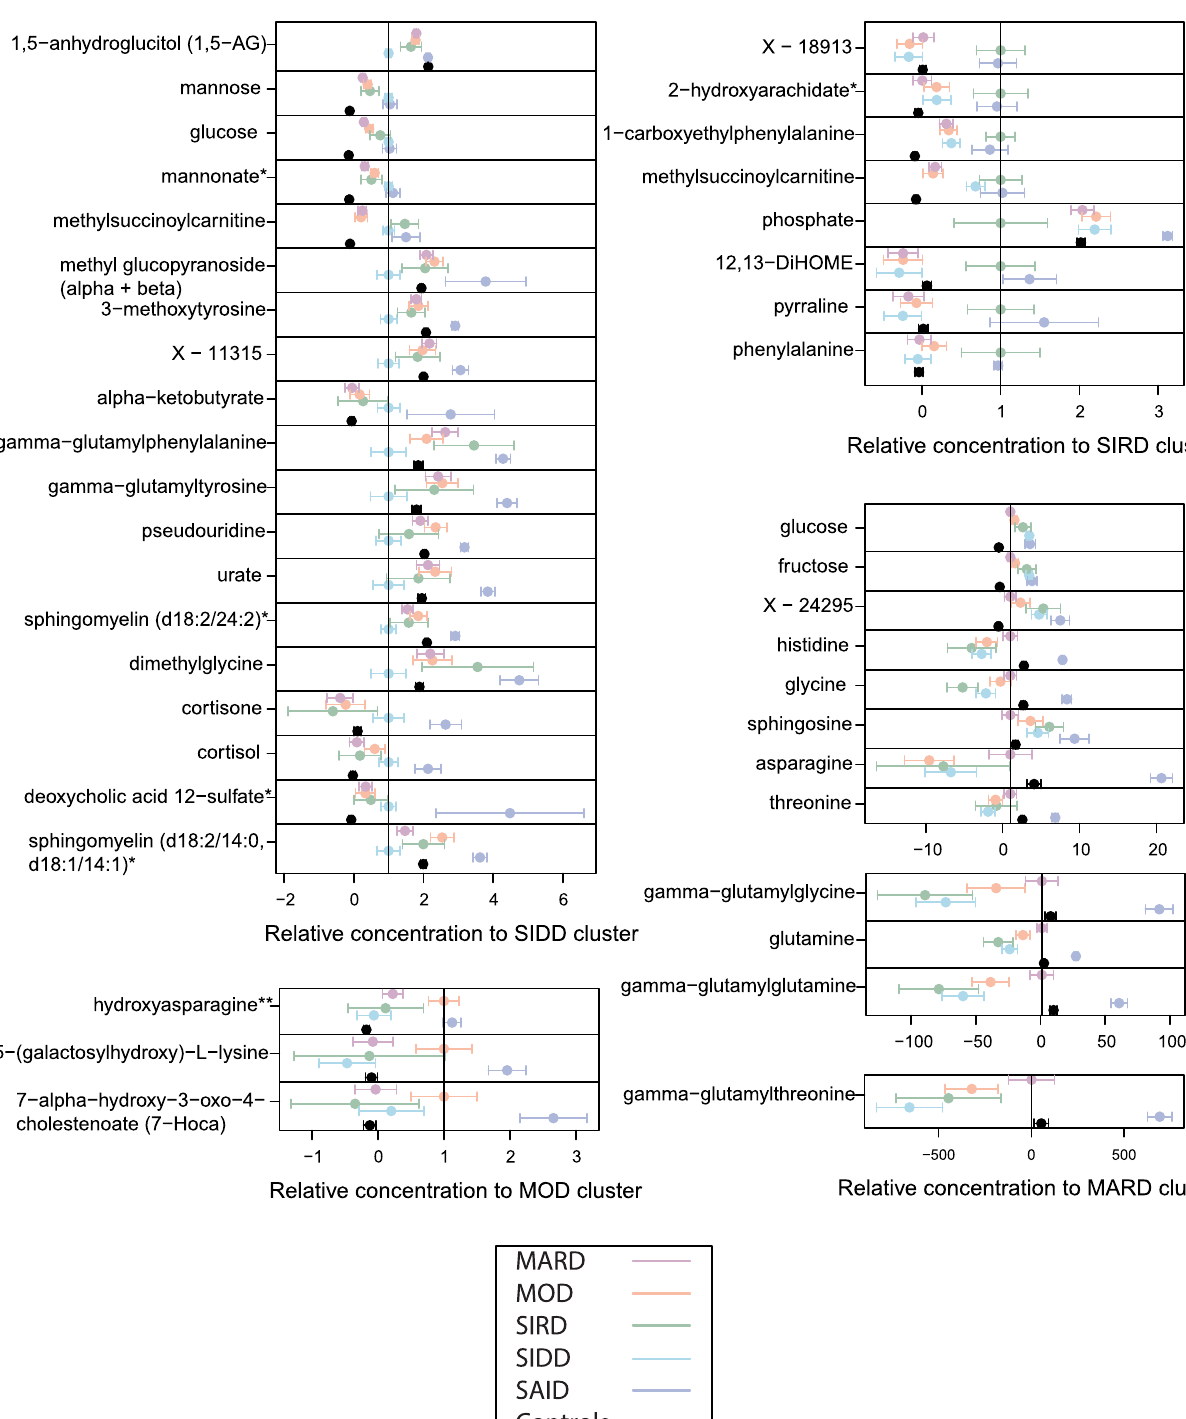
linear regression model. Proteomics PC2, PC7, and PC4 yielded the highest R2 of 15.5%, 14.3%, and 10.0%, respectively. Similarly, the